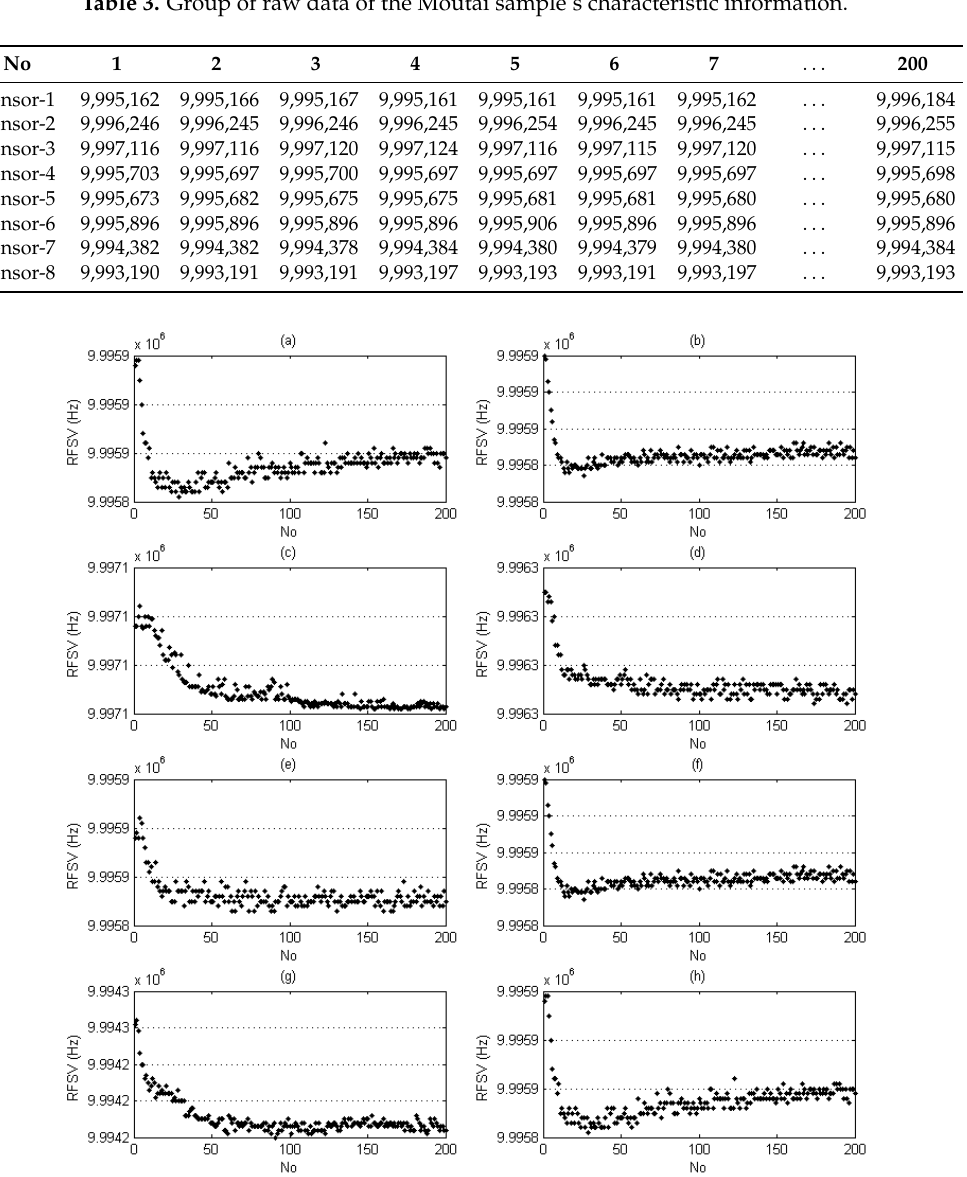
Table 3. Group of raw data of the Moutai sample’s characteristic information.